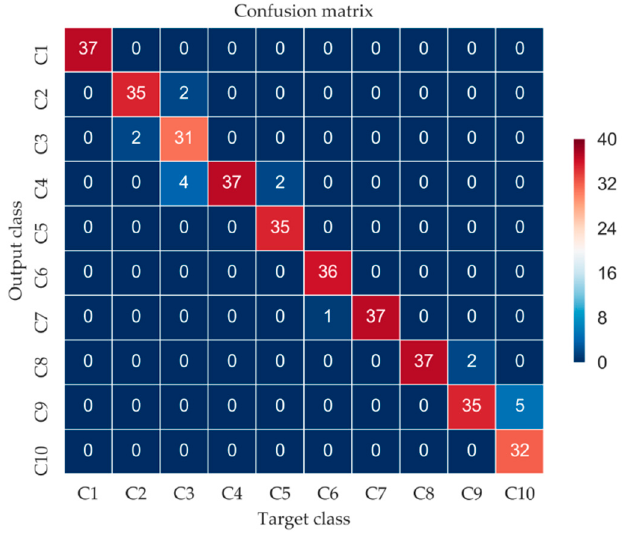
Figure 17. Confusion matrix.